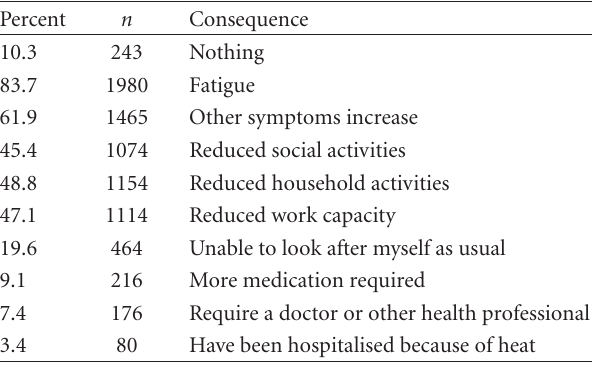
Table 1: Hot and nights days in Australia over time.